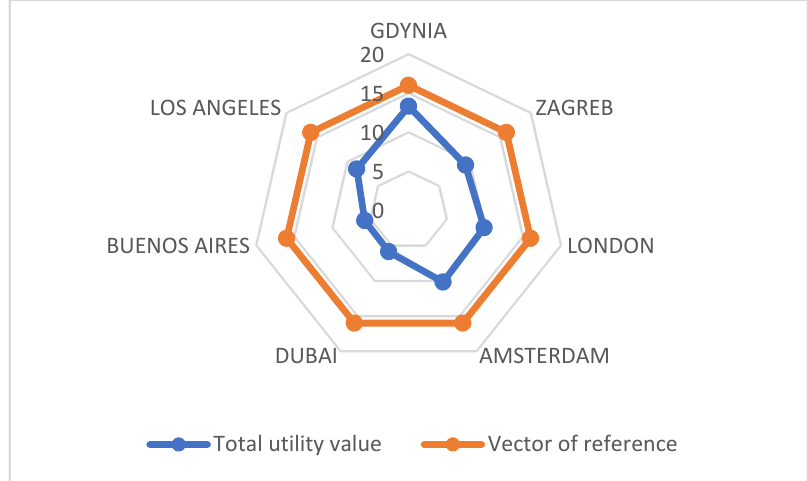
Energies 2022 , 15 , x FOR PEER REVIEW 12 of 17